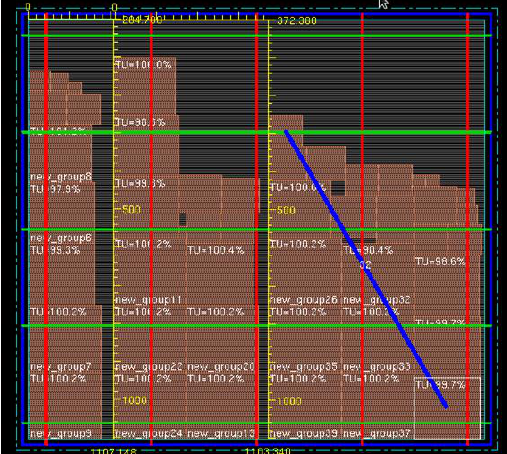
Figure 4. Layout: After implementation of proposed early clock floorplanning in DSP_CORE.